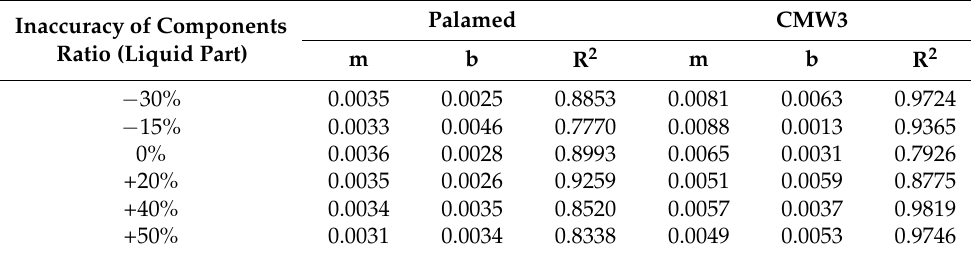
Table 1. Parameters of linear model of moisture uptake (mx +